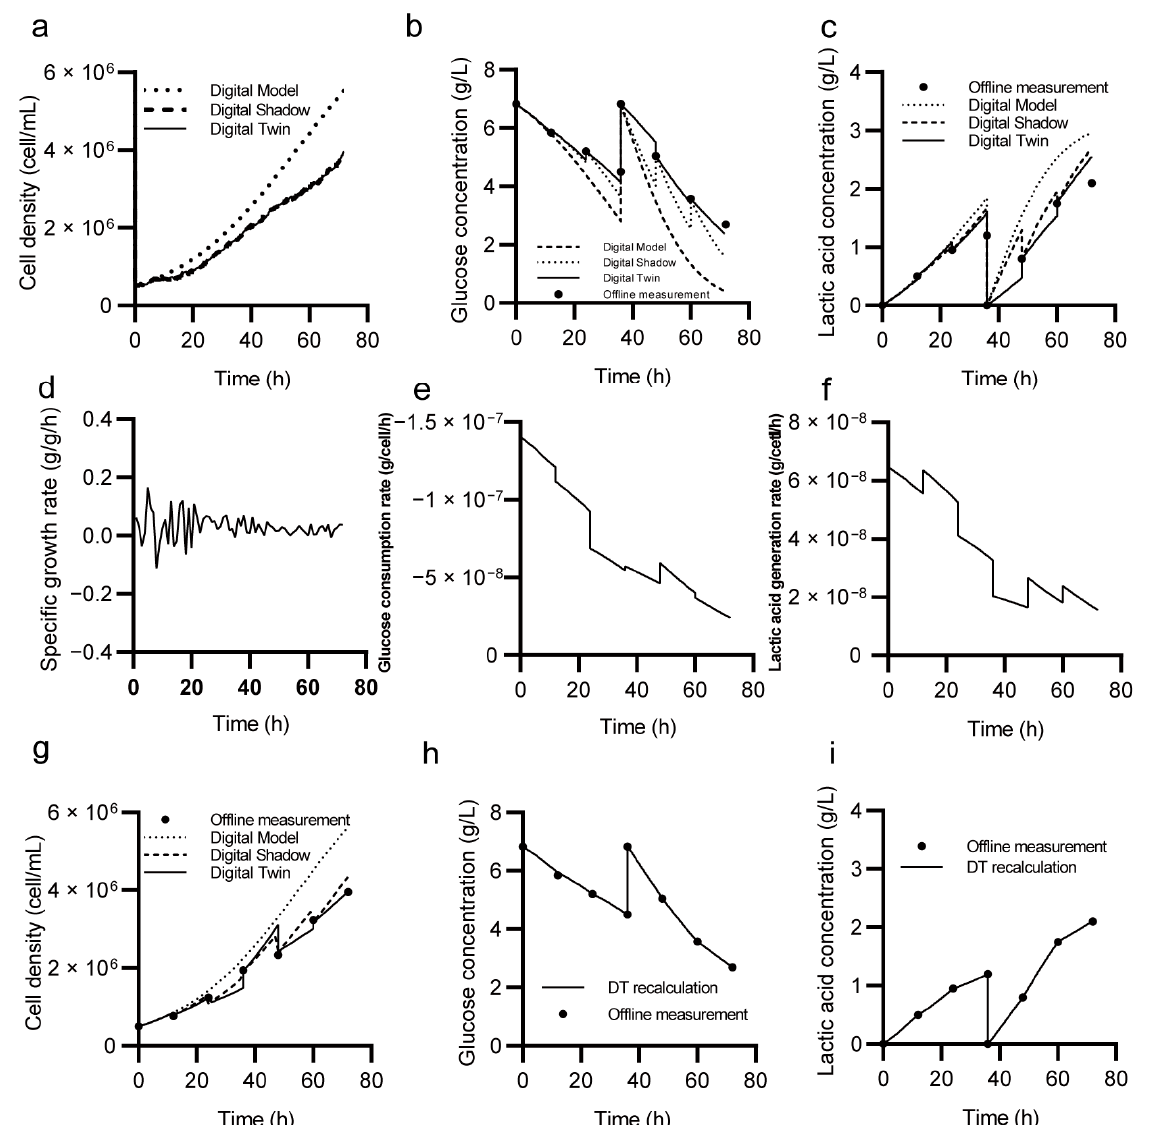
Figure 5. ( a – c , g ) Comparation between the predictions of the digital model, the digital shadow and the digital twin on cell density, glucose and lactic acid concentration. ( d – f ) Changes tracked by the digital twin on the specific growth rate, glucose consumption rate and lactic acid generation rate over time. ( h , i ) Comparation between recalculated data and sampling data of glucose and lactic acid concentrations.